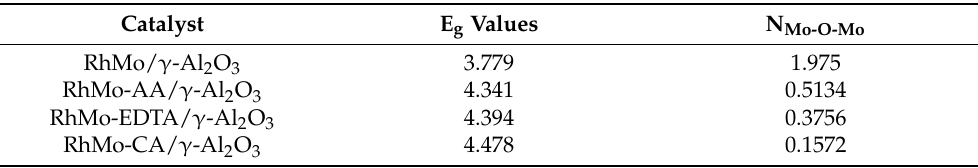
Table 1. Band gap energy and average number of nearest Mo 6+ neighbors (N Mo-O-Mo ) in deposited clusters, as determined from UV spectra of the oxide RhMo catalysts.